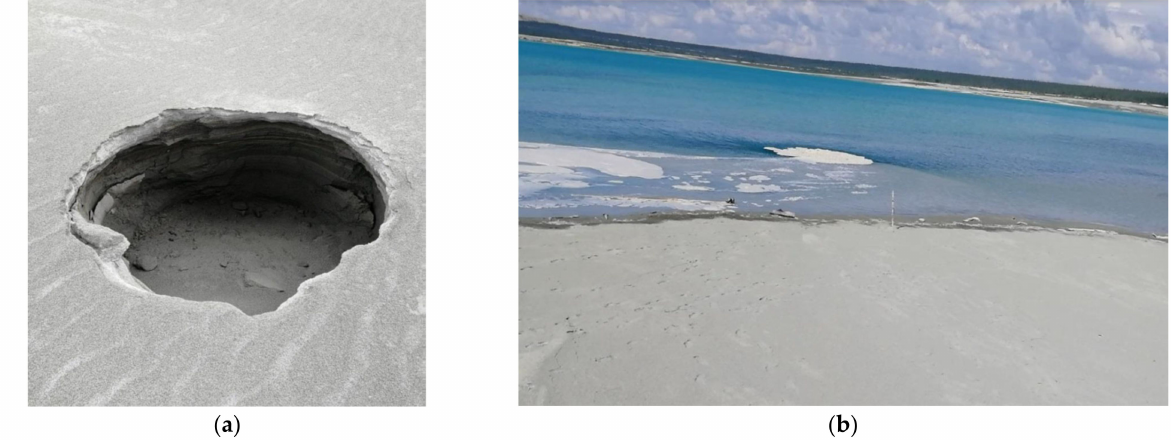
Figure 9. The sinkhole on the beach ( a ) and the place of the leachate entrance in the pond ( b ) on the left bank of the tailing dump